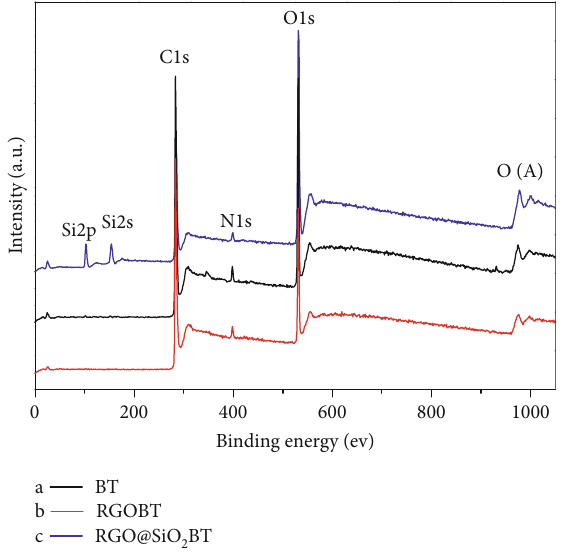
BT 2 Figure 5: XPS spectra of BT (a), RGOBT (b), and RGO@SiO